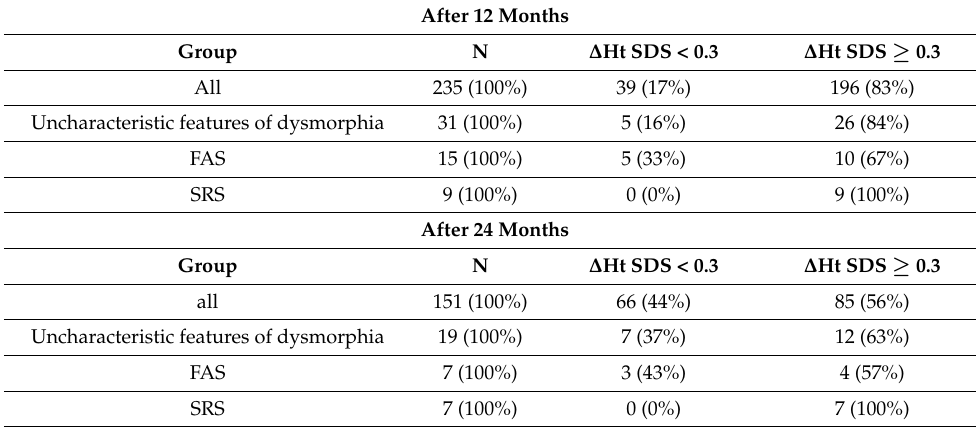
Table 3. Response to rhGH treatment in different subgroups.